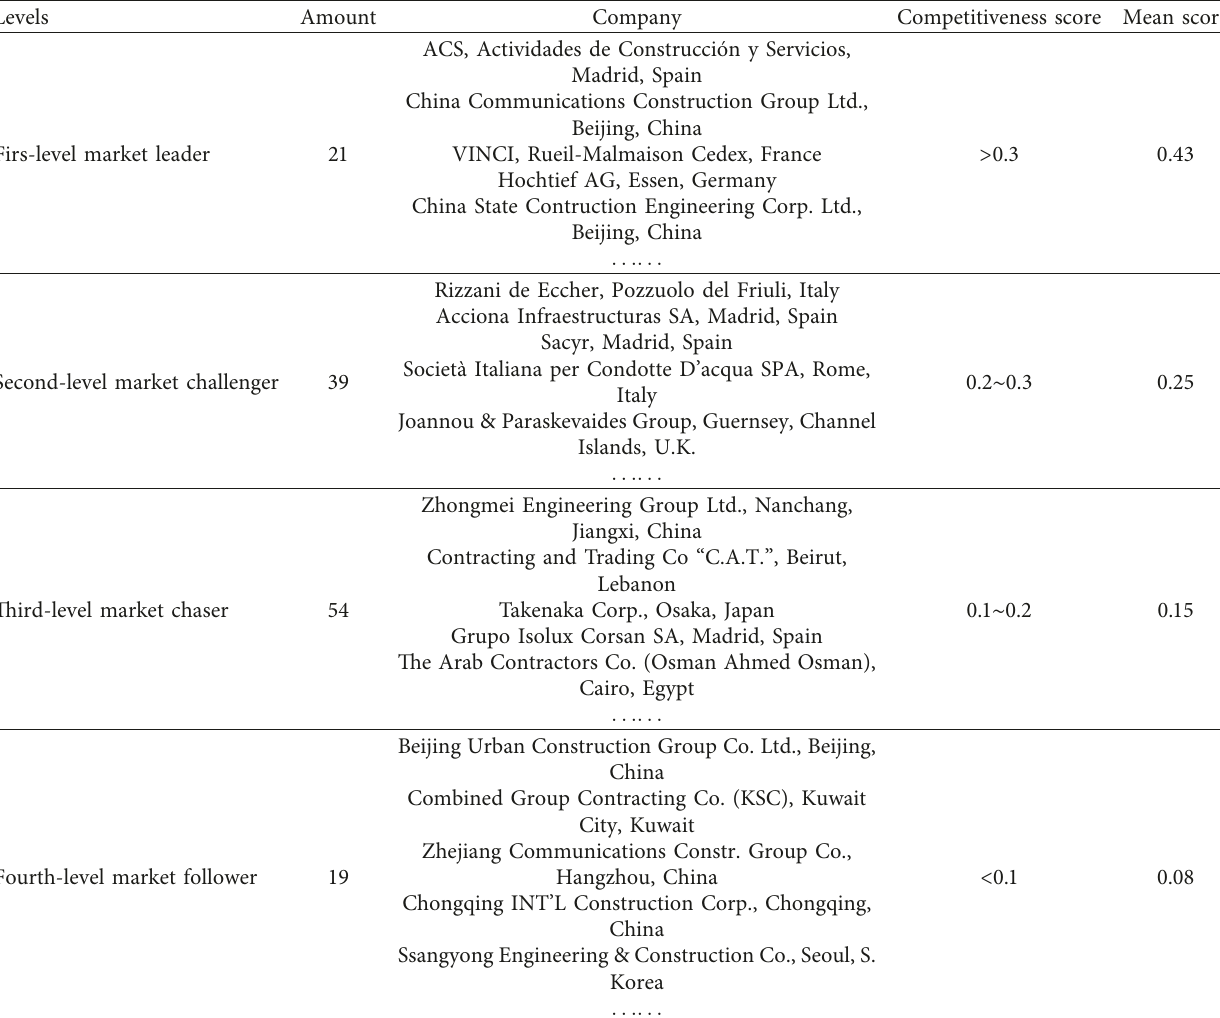
Table 5: Clustering analysis of international HSR construction contractors’